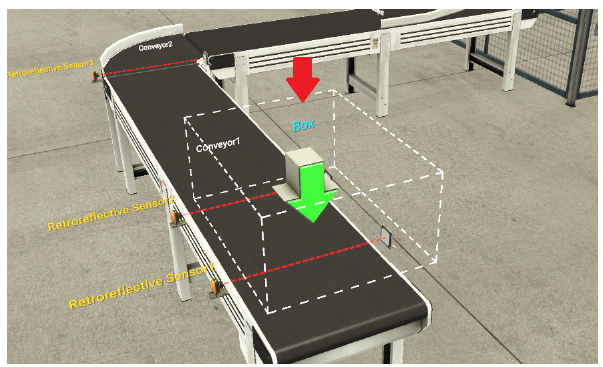
Figure 7. Emitter.